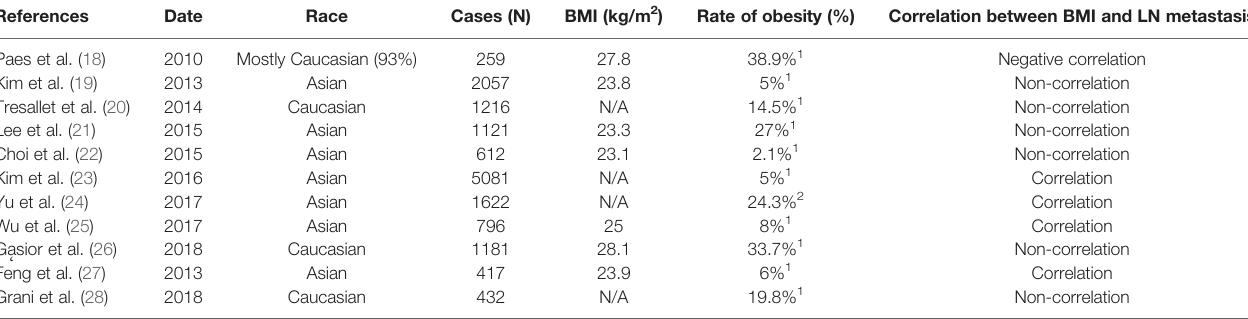
TABLE 8 | Previous studies on the relationship between obesity and LN metastasis of thyroid cancer.